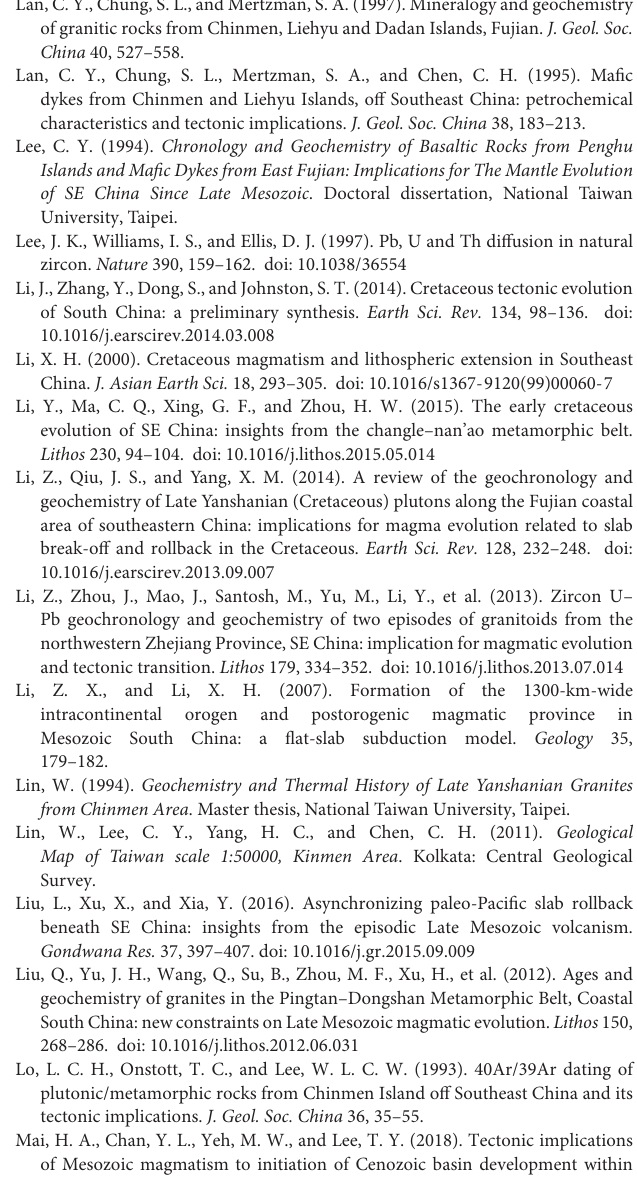
TABLE S1 | Measured structural data in the form of dip direction and dip for planar structures, and as trend and plunge for linear